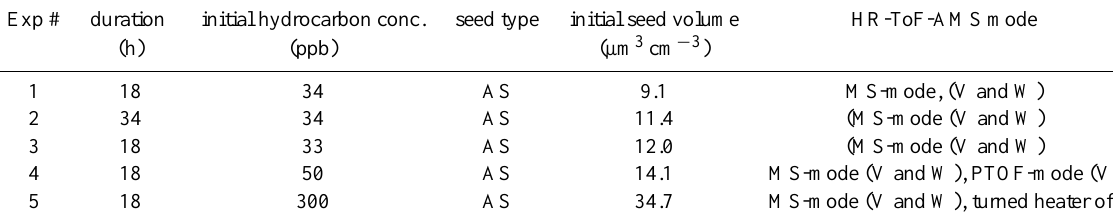
Table 1. Experimental conditions for dodecane low-NO x photooxidation. Exp # duration initial hydrocarbon